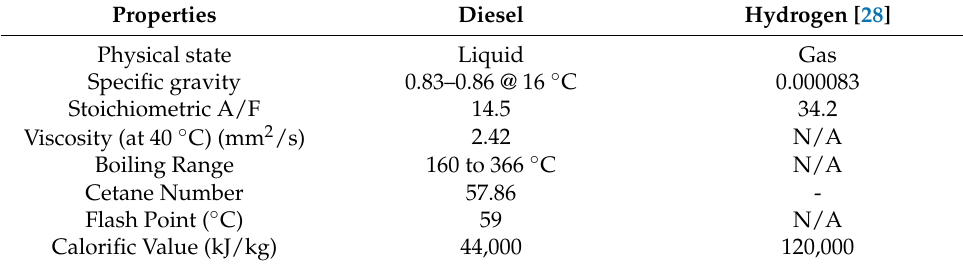
Table 2. Properties of test